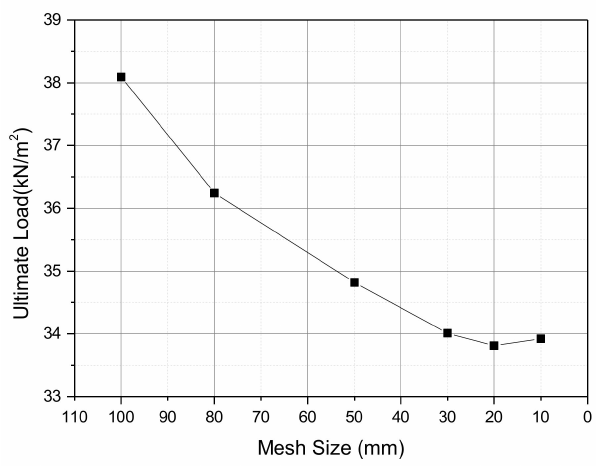
Figure 3. The results of the convergency